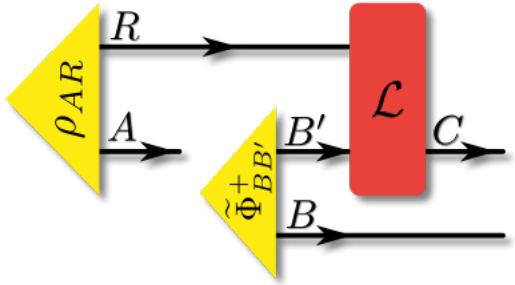
Figure 7: CJI of a two-step process . Υ an unnormalized maximally entangled state and the degrees of freedom denoted by R . Note that we let L act on B ( H this is merely a relabelling for notational